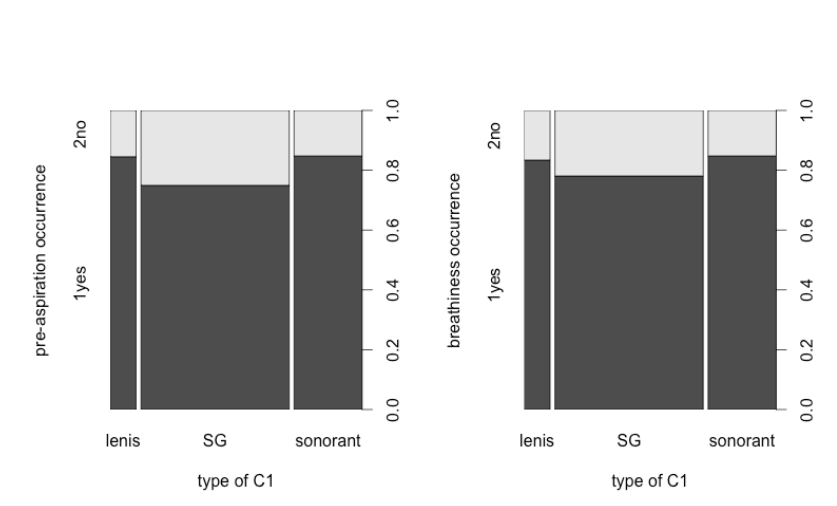
Figure 3: Frequency of occurrence, for pre-aspiration (left) and breathiness (right), de- pending on the type of C 1 .